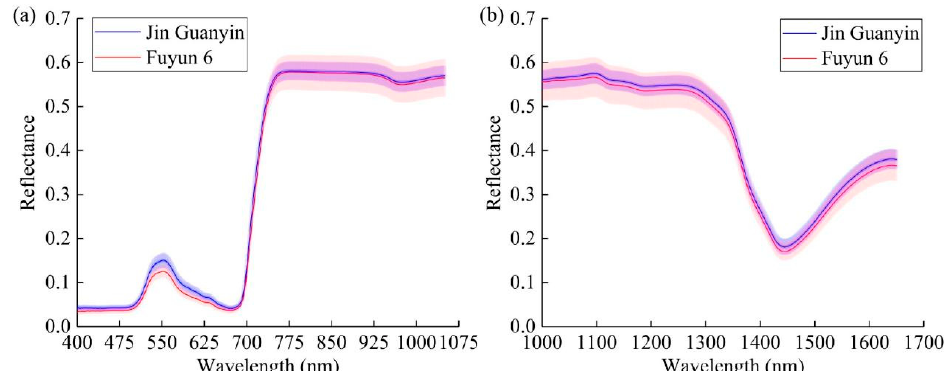
Figure 4. Raw spectra of fresh tea leaves in different waveband ranges. Mean ± standard deviation of the samples from two different tea varieties. The upper and lower boundaries of the translucent areas represent ± standard deviation. ( a ) Vis/short-wave NIR spectra (400–1050 nm), ( b ) long-wave NIR spectra (1000–1650 nm).